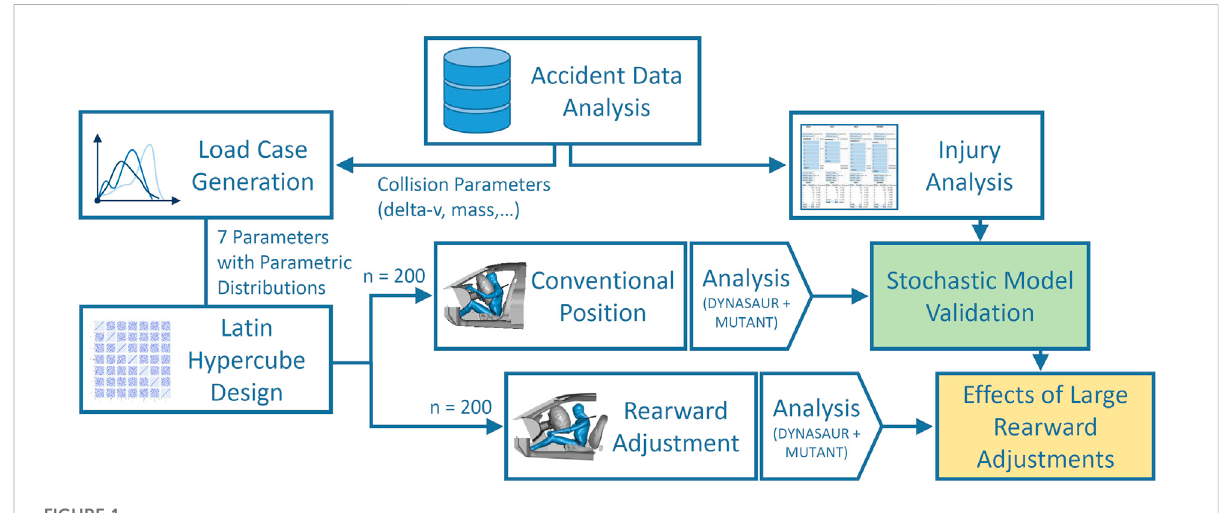
FIGURE 1 Graphical representation of the approach of the present